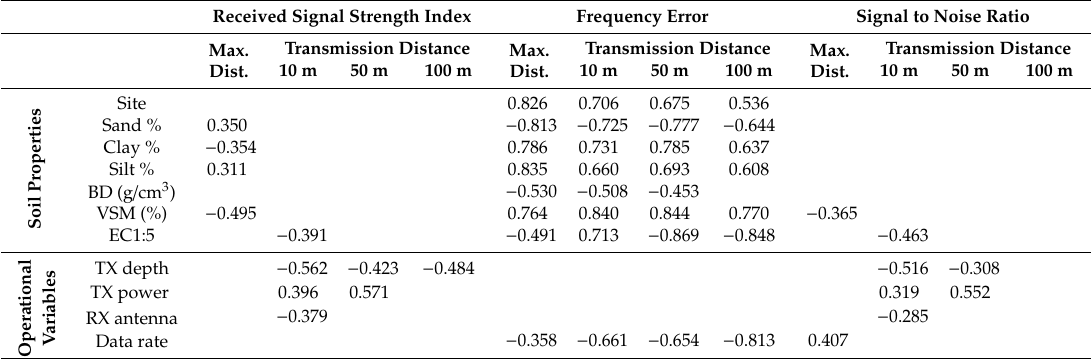
Table 4. Pearson correlation (R values) of soil properties and operational parameters on transmission distance and signal